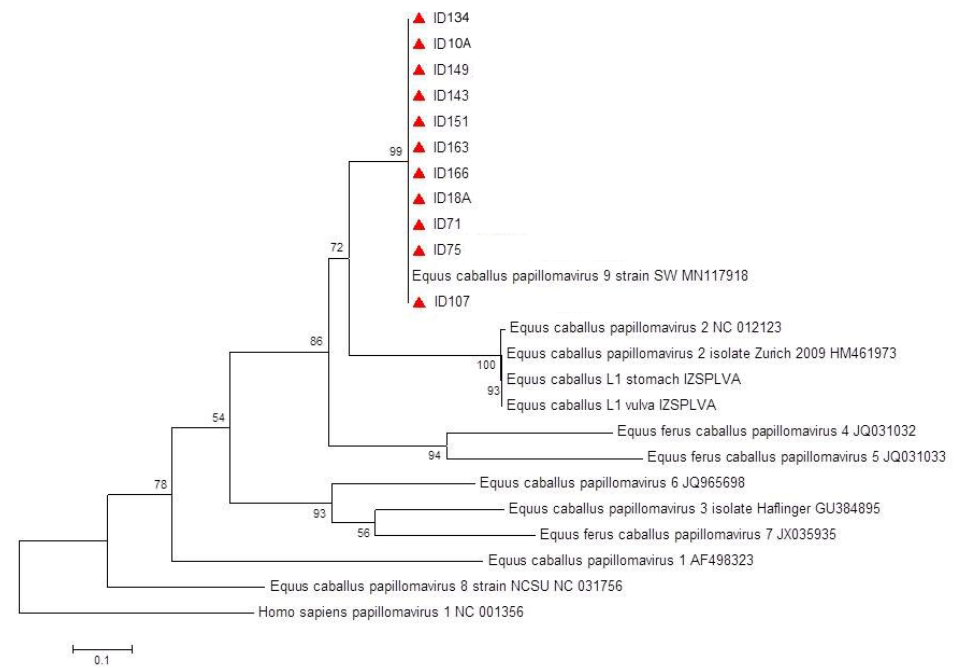
Figure 1. Phylogenetic tree. Phylogeny was inferred by maximum likelihood (ML) analysis obtained by an alignment of 533 bp of the L1 gene of EcPV. EcPV type and GenBank accession numbers are indicated. Sequences generated in this study are indicated by a red triangle. Bootstraps (1000 replicates) values >50 are shown at the internal nodes. The length of each pair of branches represents the distance between sequence pairs. The scale bar represents the percentage of nucleotide differences.